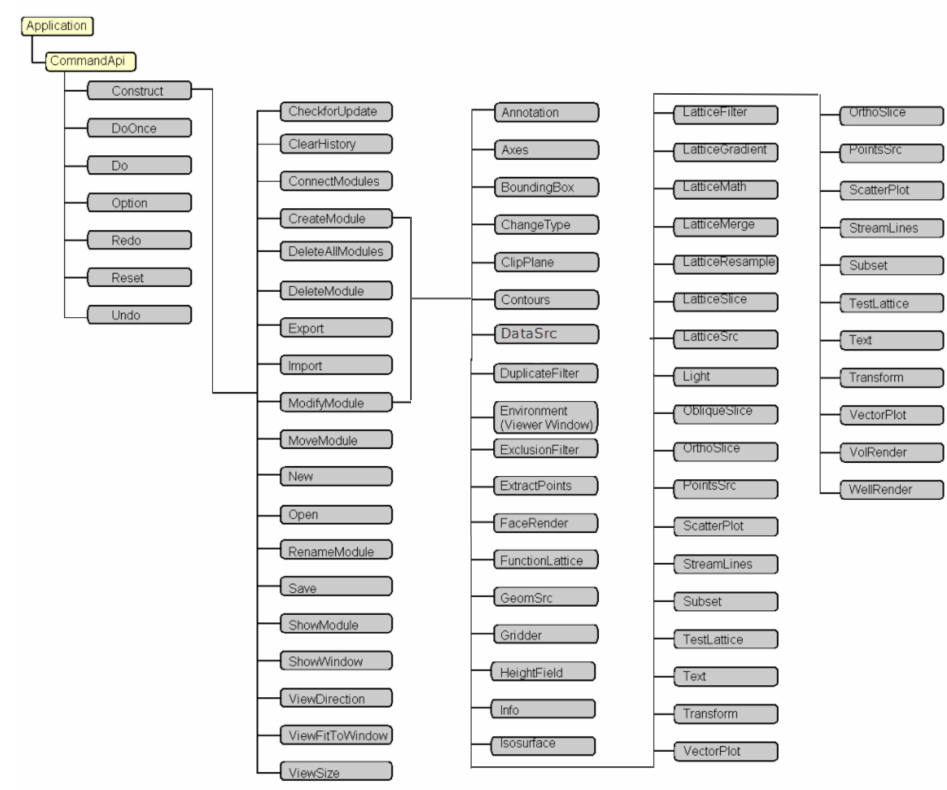
Figure 6. Voxler automation model [20], including objects (yellow boxes), methods, as well as properties (gray